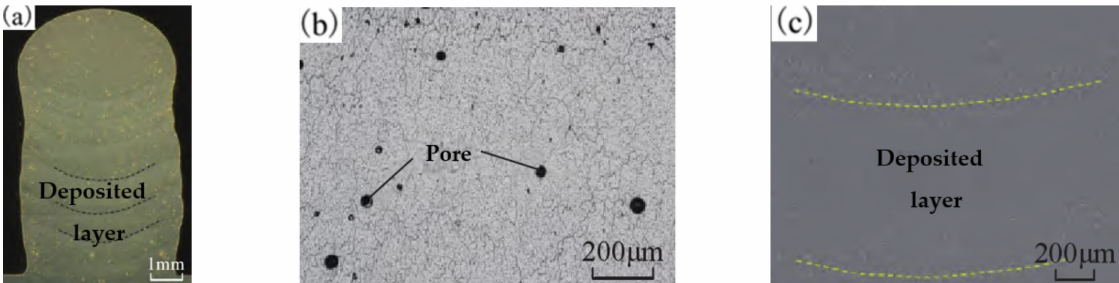
Figure 3. Metallographic and SEM images of 7075 aluminum alloy [16]. ( a ) Deposition characteristics of deposited layer in the stable section of arc additive manufacturing. ( b ) Metallographic structure diagram of deposited layer. ( c ) Microstructure of the deposited